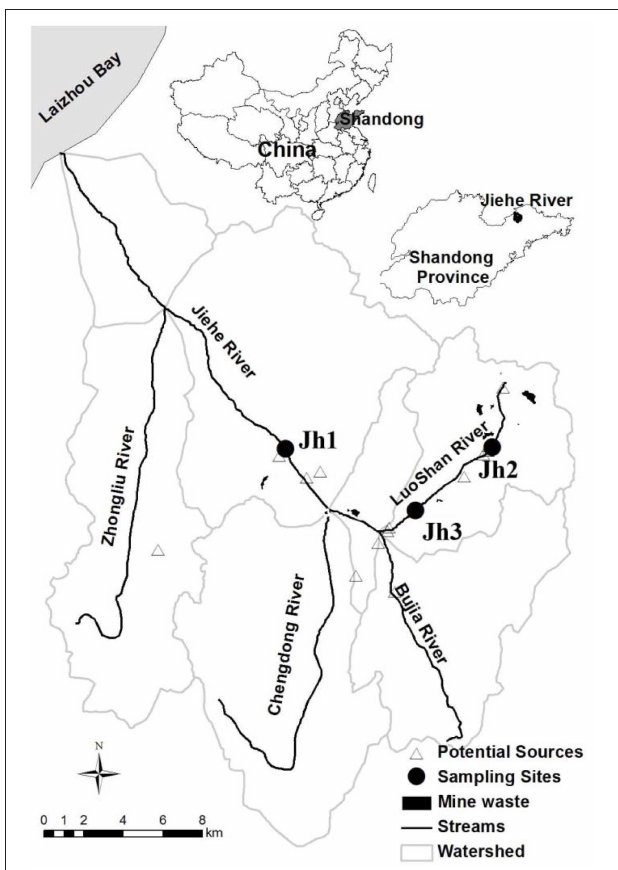
FIGURE 1 | Location of the sampling points in the Jiehe (Jh) River watershed. The location of the sediment samples for this study is presented by solid circles (Zhang et al.,